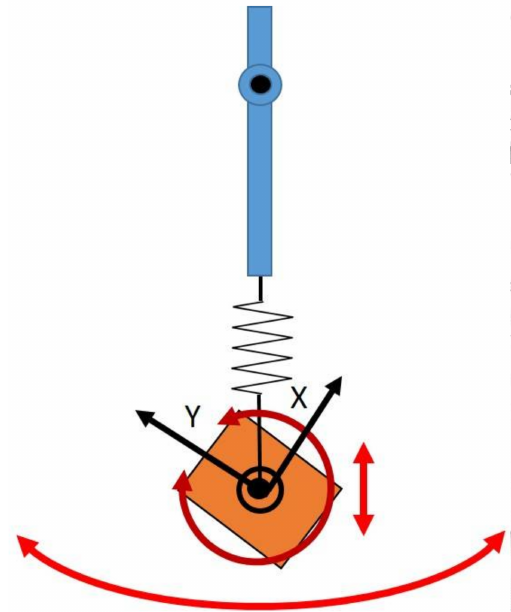
Figure 5. Diagram showcasing the modifications made to the simulated pendulum to achieve a better approximation of STA. The Z axis is perpendicular to the XY plane as defined by the right-hand